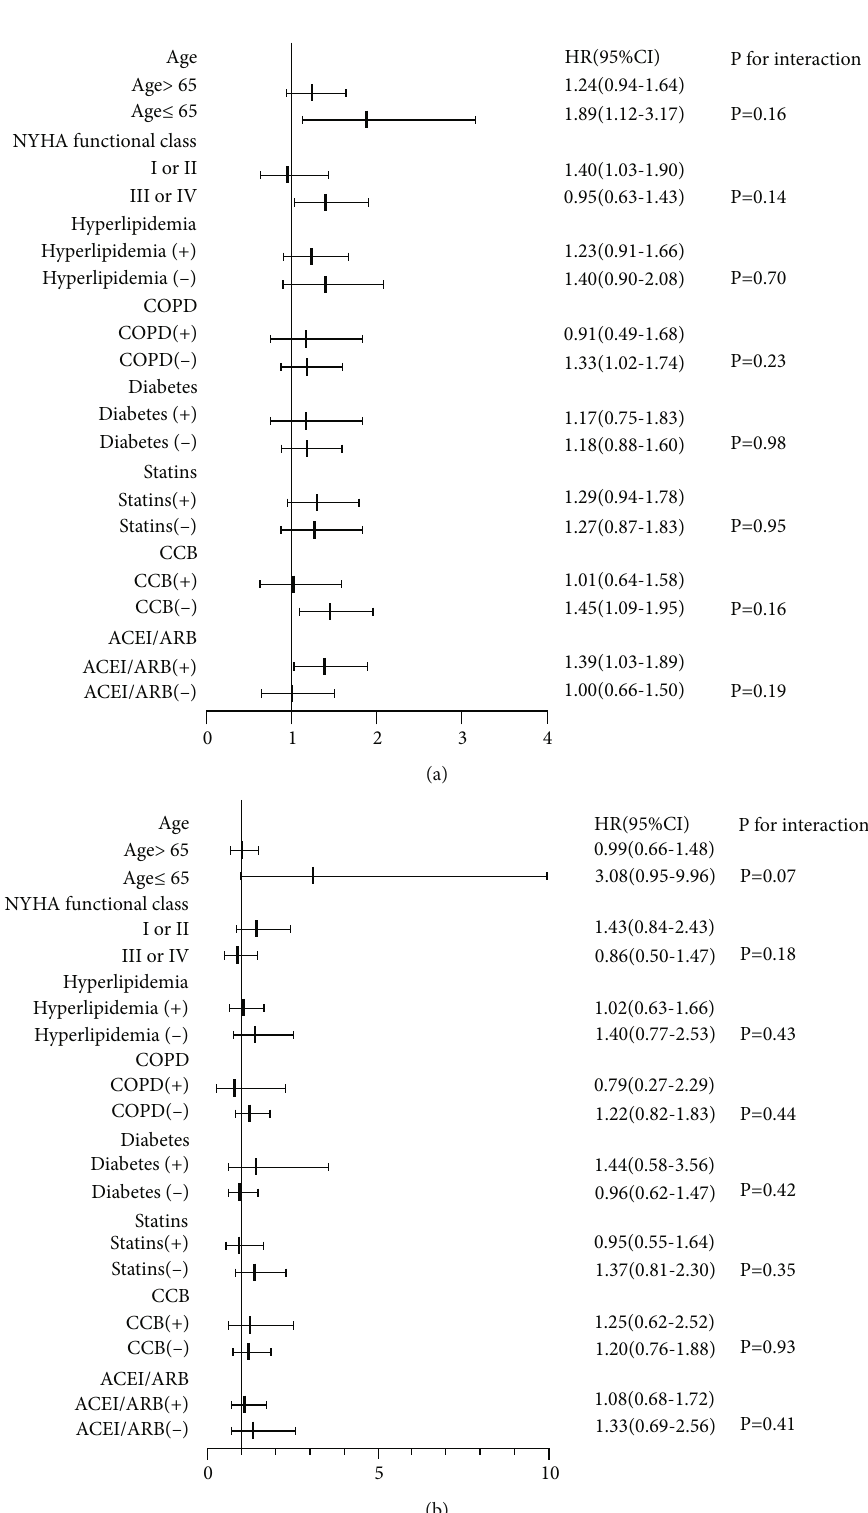
Figure 2: Association between abdominal obesity and all-cause mortality in the subgroups, (a) males and (b) females. COPD: chronic obstructive pulmonary disease; CCB: calcium channel blocker; ACEI: angiotensin-converting enzyme inhibitors; ARB: angiotensin II receptor blockers; NYHA: New York Heart